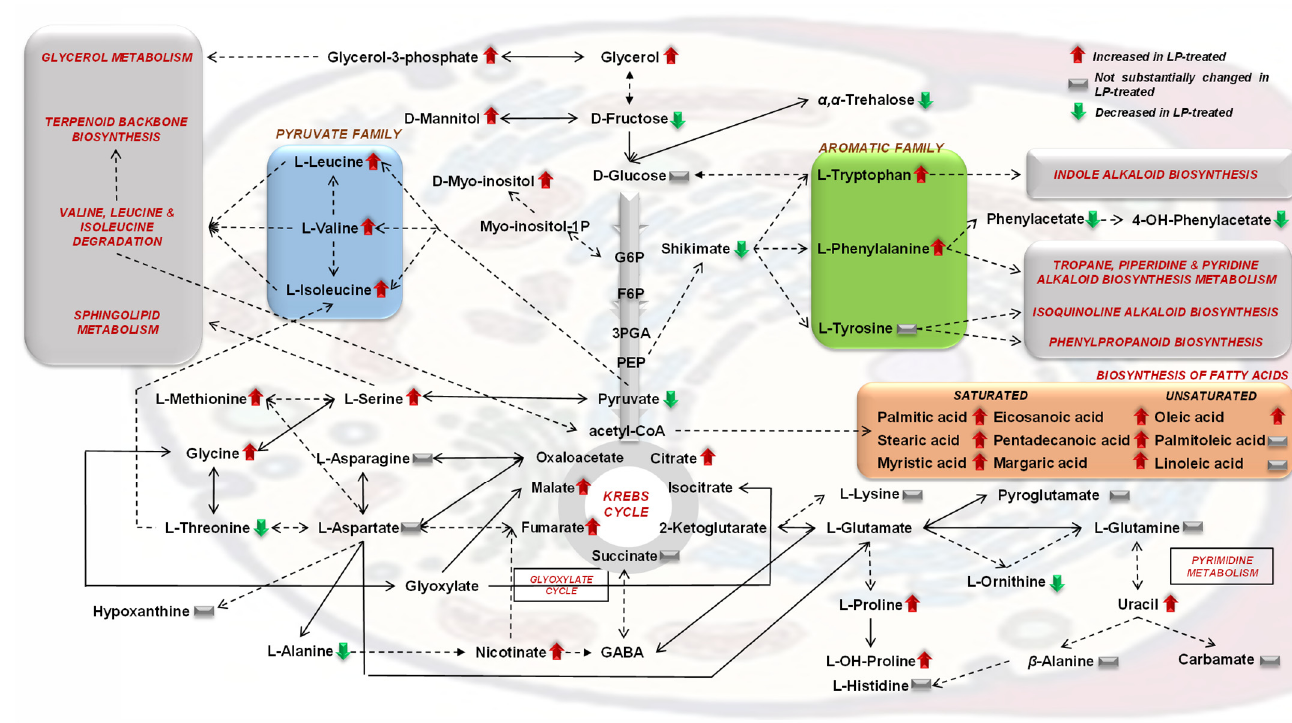
Figure 8. De novo constructed metabolite network of Colletotrichum acutatum . Arrows indicate the impact of the applied LP extract of the olive tree endophytic Bacillus sp. PTA13 on the levels of its metabolites; upward red arrows indicate elevated levels following LP treatment, whereas downward green arrows indicate reduced metabolite levels. Fluctuations are color-coded based on the means of scaled and centered PLS regression coefficients (CoeffCS). Solid lines correspond to one-step consecutive metabolites, whereas dashed lines indicate multi-step or not fully elucidated pathway segments. For the construction of the network, data were retrieved from the Kyoto Encyclopedia of Genes and Genomes (KEGG).